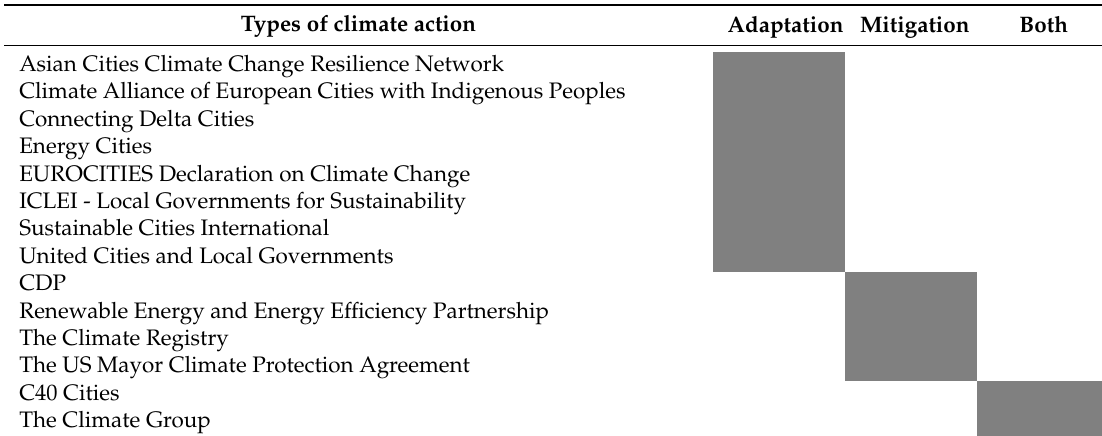
Table 3. Assignment of city networks to different types of climate